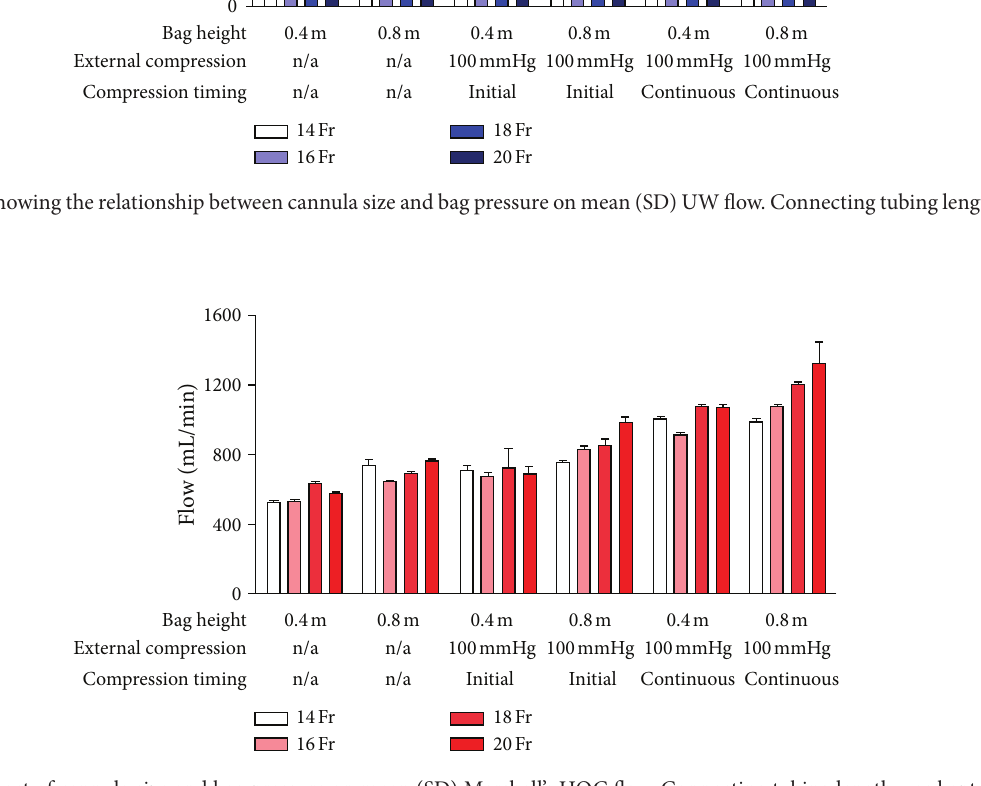
Figure 4: The impact of cannula size and bag pressure on mean (SD) Marshall’s HOC flow. Connecting tubing length was kept constant at